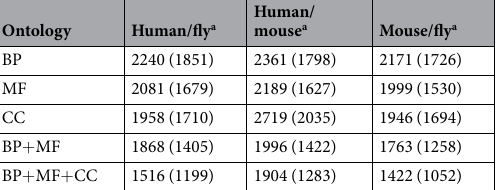
Table 2. Number of orthologous gene pairs used in this study. a Numbers refer to IEA ( + ) data sets, whereas numbers in parentheses refer to IEA ( − ) data